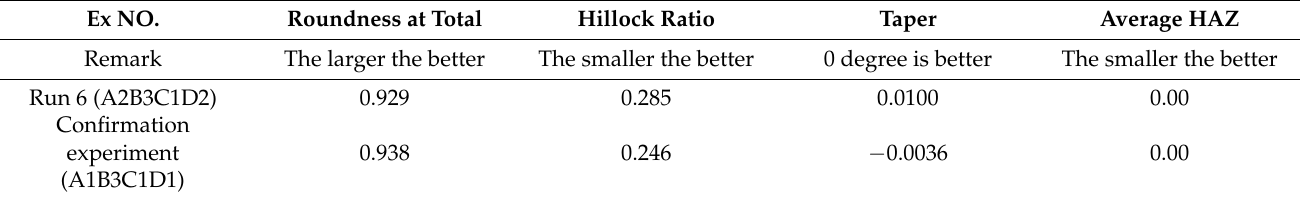
Table 9. Comparison of confirmation experimental results and optimal multiple qualities (Run 6).